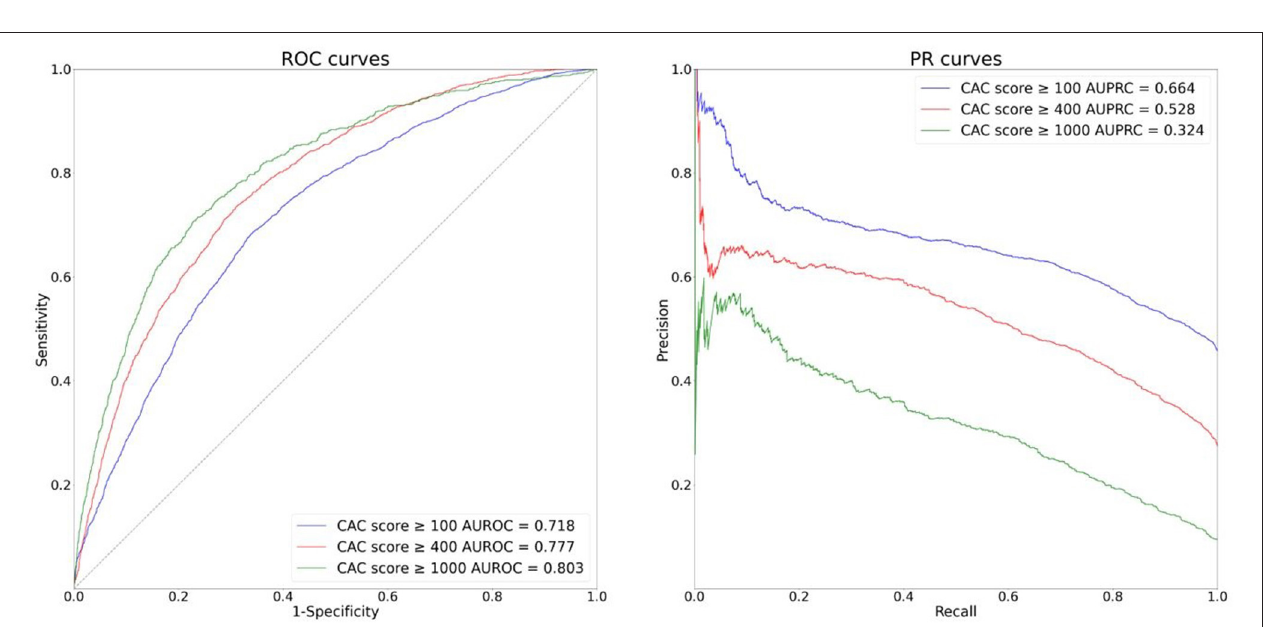
FIGURE 3 | Average ROC and PR curves of the 5-fold cross validation. The solid lines depict the average ROC and PR curves and the shaded areas depict ± 1 standard deviations of the curves.